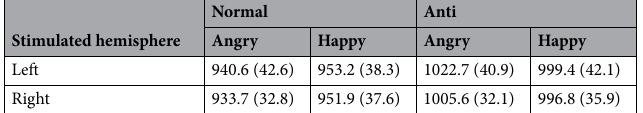
Table 2. Mean (± SE ) reaction times (ms) in the visual-search task in controls.